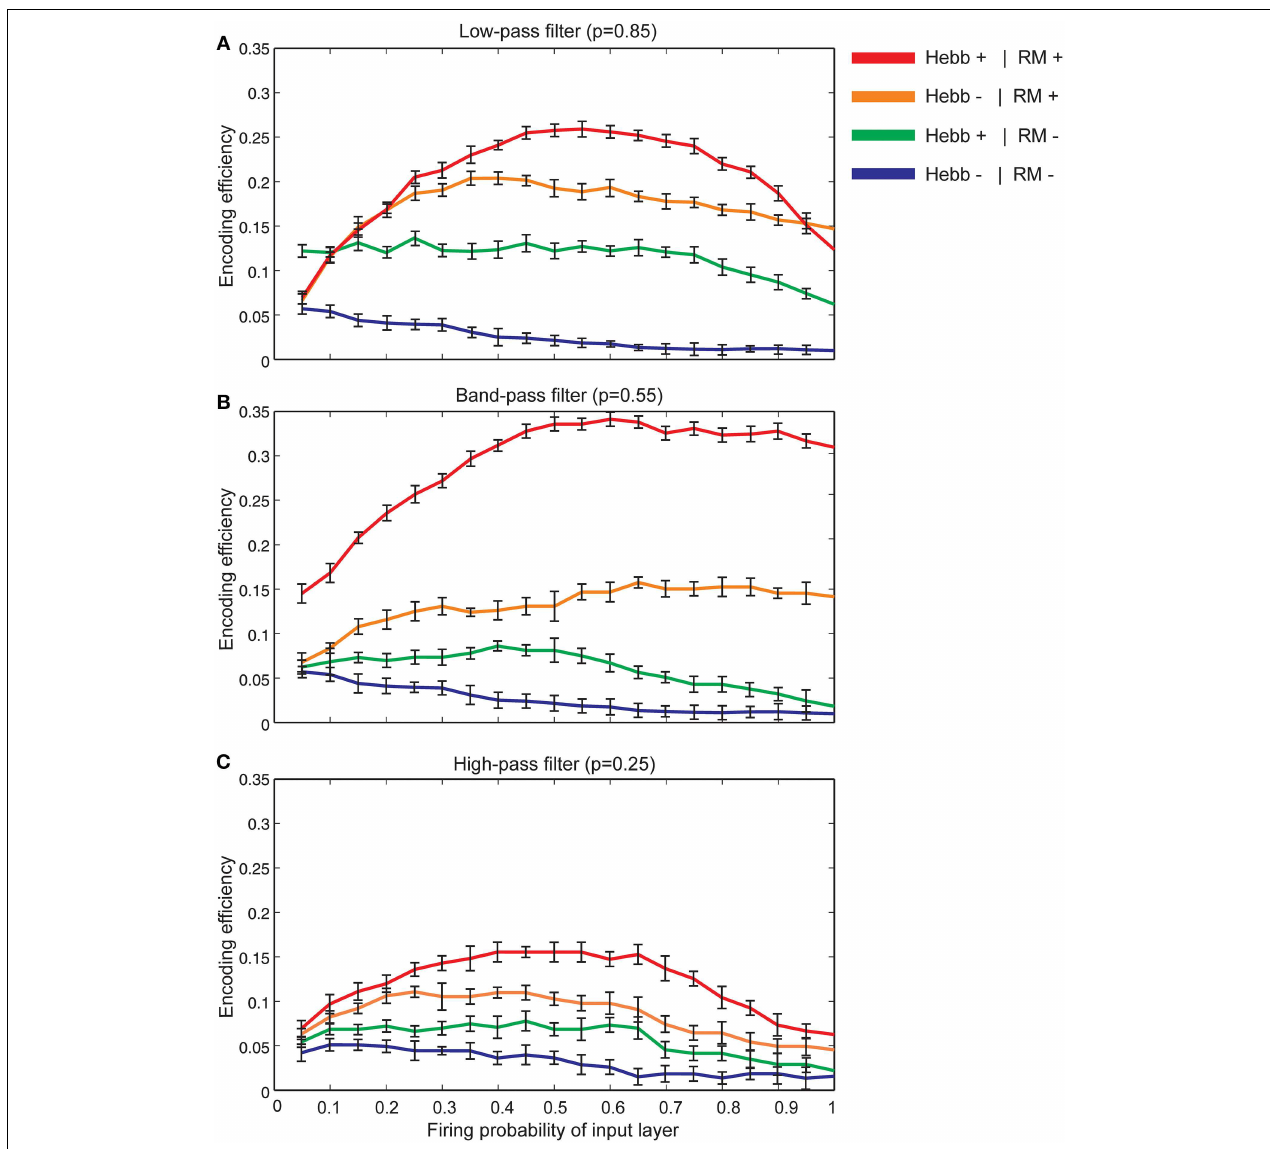
mechanisms (shown as green and blue lines, respectively). Hebb + stands for existing Hebbian mechanism and RM stands for existing of retrograde messenger based induced activity. (B) Synapses as band-pass filters. Initial release probability was set to 0.55. In comparison to low pass-filters, when both Hebbian mechanism and homeostatic regulation mechanism of retrograde messenger exist, studied a single neuron demonstrates higher encoding efficiency. (C) Synapses as high-pass filters. Initial release probability was set to 0.25. In comparison to low and band-pass filters, studied single neuron shows low encoding efficiency for all synaptic